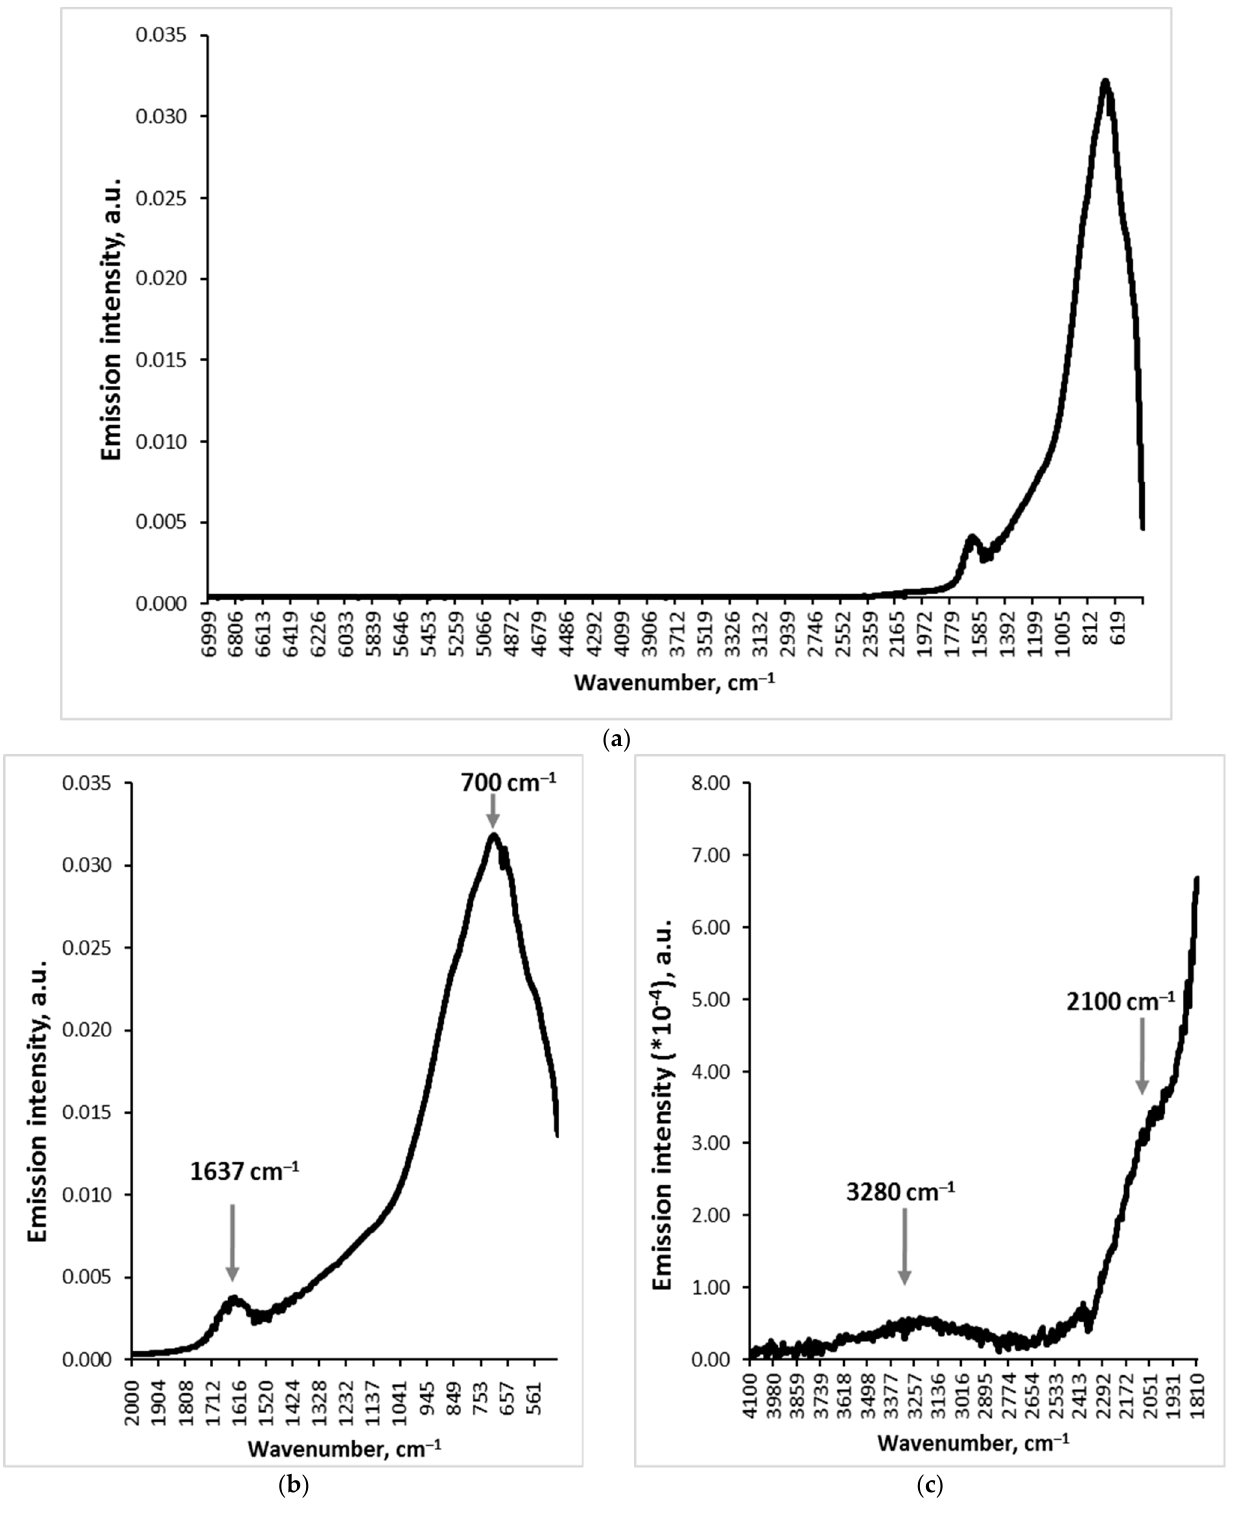
Figure 1. The spectrum of intrinsic emission of water. ( a ) full recorded emission spectrum in the range of 430–7000 cm − 1 , ( b ) zoomed spectral region in the range of 470–2000 cm − 1 , and ( c ) zoomed spectral region in the range of 1810–4100 cm − 1 .